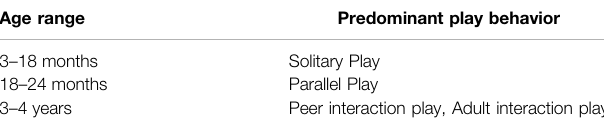
TABLE 1 | Predominant play behavior based on age. Age